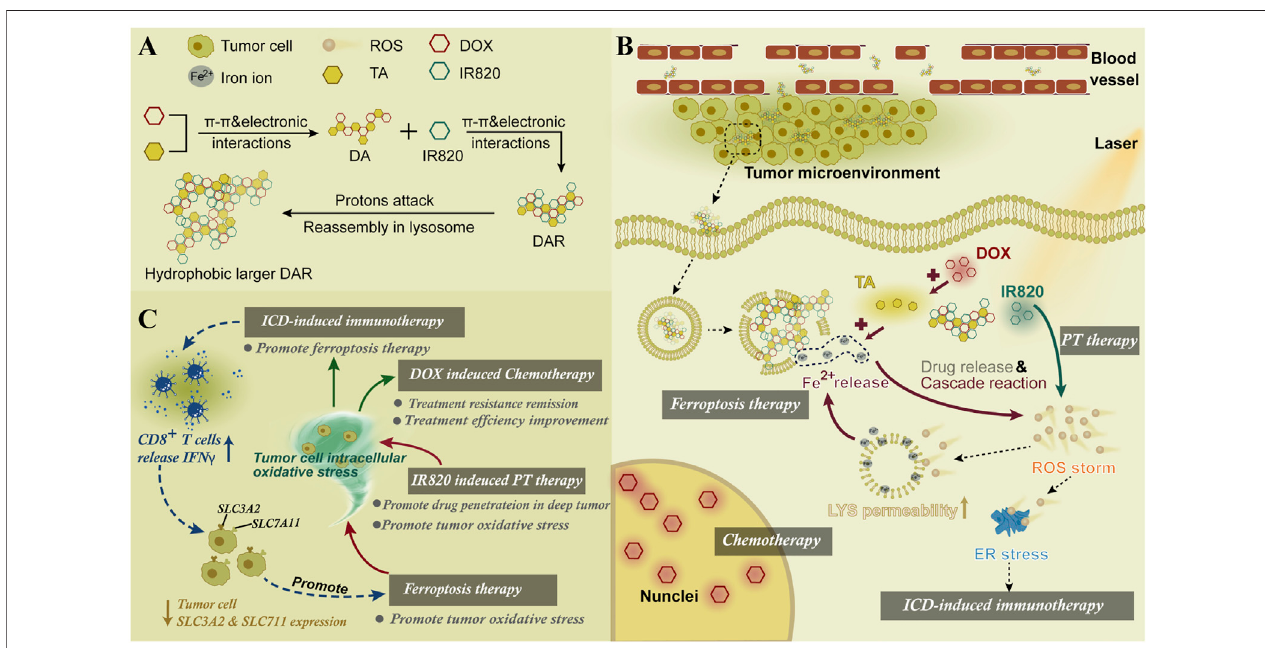
FIGURE 13 | (A) Synthesis scheme of DAR. (B) Mechanism of DAR for cancer therapy. (C) Combined therapy mechanisms of DAR. Adapted from Xiong et al., (2021) Copyright @ 2021 (Elsevier).